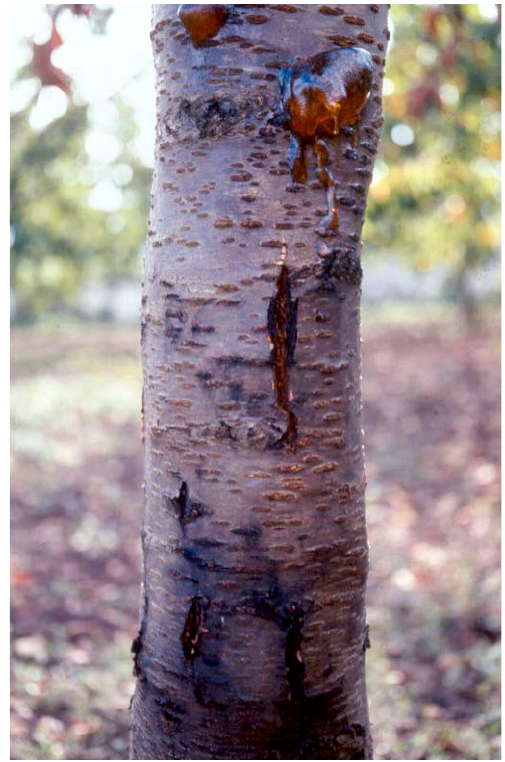
Figure 2. Gummy exudates oozing from the trunk of a sweet cherry tree affected by Leucostoma canker.